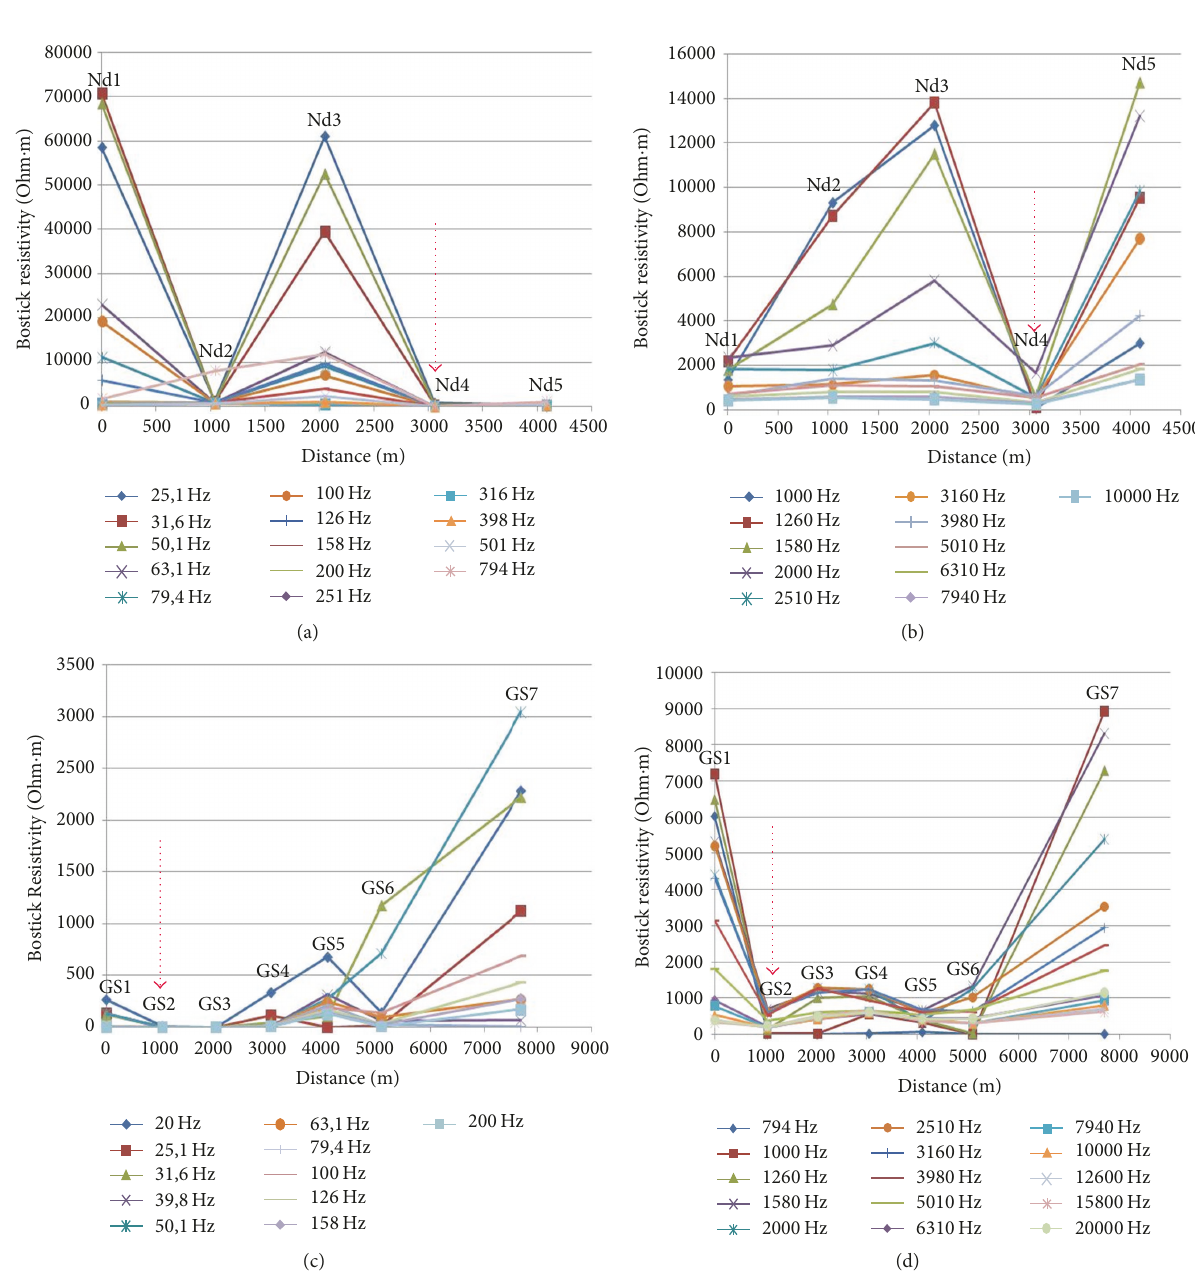
Figure 8: Resistivity profiling curves for Ndokayo profile, respectively, at low frequencies [ 25.1 Hz–501Hz] (a) and at high frequencies [ 794 Hz–10000 Hz] (b); resistivity profiling curves for Garga Sarali profile, respectively, at low frequencies [ 20Hz–200 Hz] (c) and at high frequencies [ 794 Hz–20000 Hz]